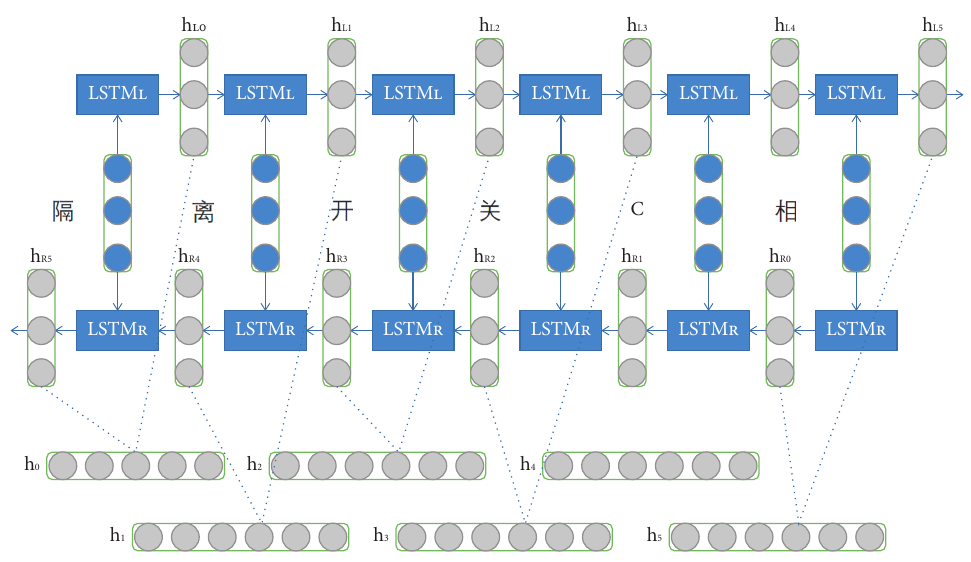
Figure 7: The structure of